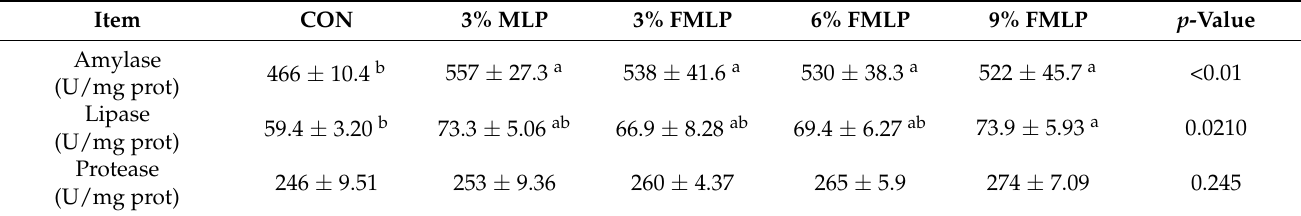
Table 5. Effects of FMLP on digestive enzyme activity in jejunum of broilers.